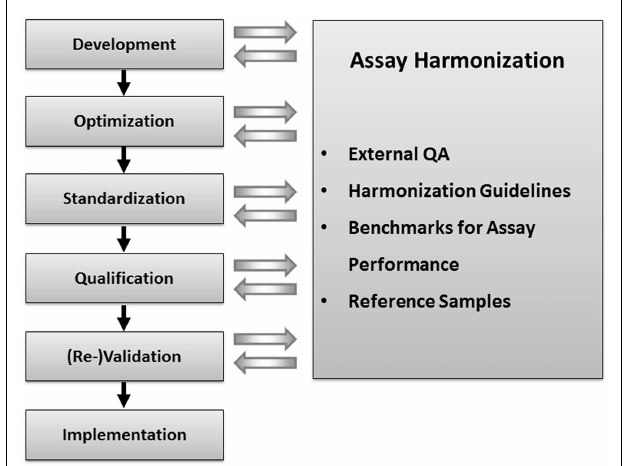
FIGURE 1 | Concept of immune assay harmonization: external quality assurance, harmonization guidelines, benchmarks for assay performance, and reference samples with defined numbers of functional antigen-specificT cells can be used to control the performance of immune assay in one lab . Immune assay harmonization can support quality of immune assays at any step of assay development and use, starting from the initial assay development until assay